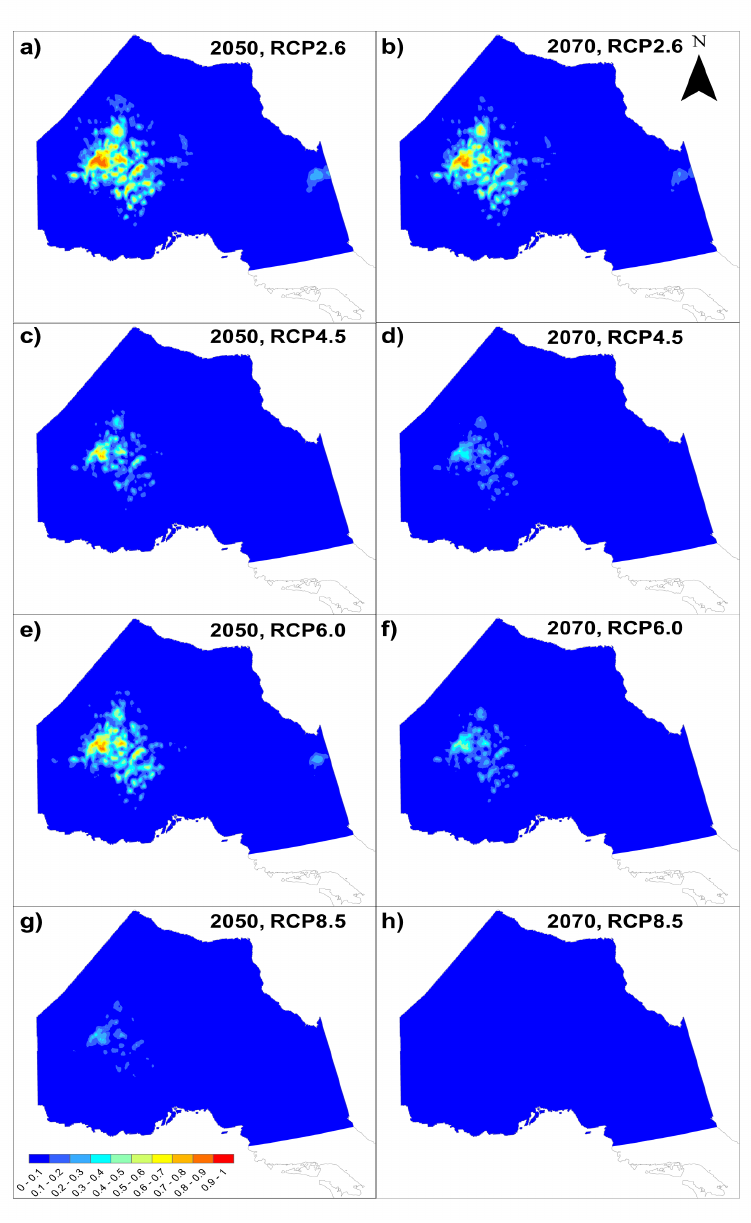
Figure 3. Future projections of caribou occurrence using 126 General Circulation Models (GCM) and greenhouse gas emission representative concentration pathway (RCP) scenarios. All fifteen RCP 2.6 (a,b), nineteen RCP 4.5 (c,d) , twelve RCP 6.0 (e,f), and 17 RCP 8.5 (g,h) projections were utilized in the projections of future caribou occurrence. Woodland caribou occurrence was forecasted using scenarios from 2050 (a, c, e and g) and 2070 (b, d, f and h). Blue regions represent low likelihoods of woodland caribou occurrence while orange, yellow, and red regions represent areas of higher likelihoods of caribou occurrence. Values are interpolated using Ordinary Krig- ing and shown at a 25 km 2